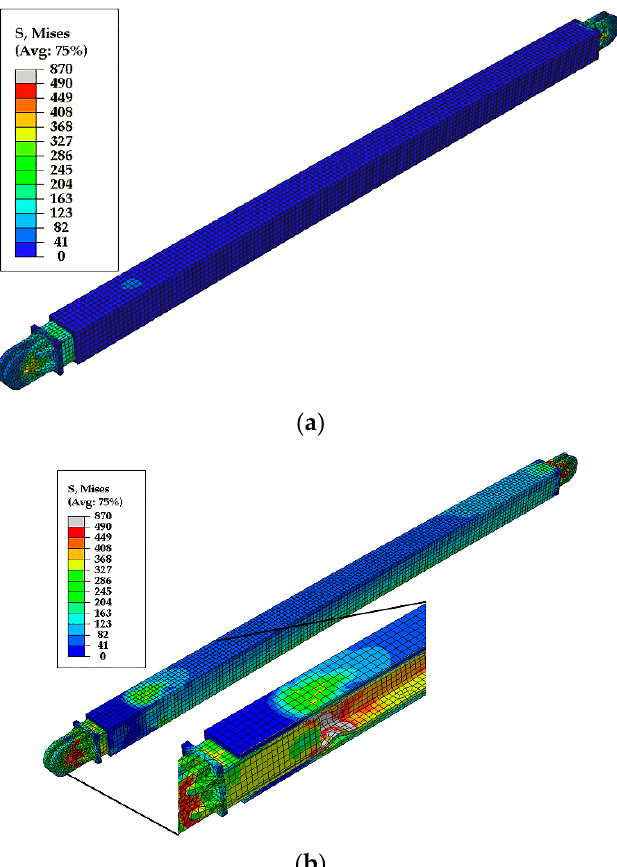
Figure 11. Casing stress ( a ) before and ( b ) after core flange buckling.